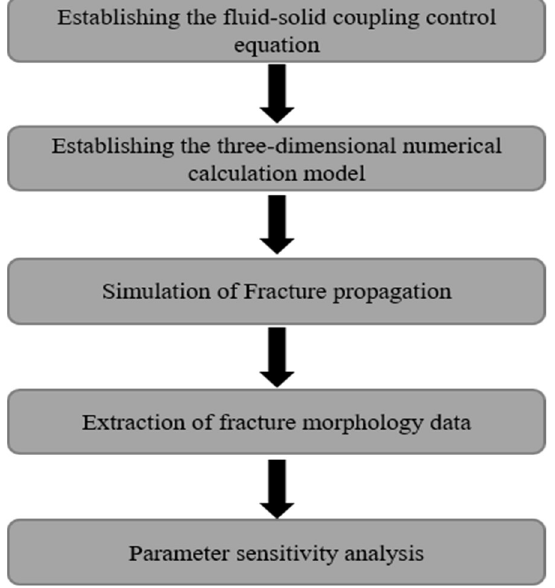
Figure 7. Workflow of this study.